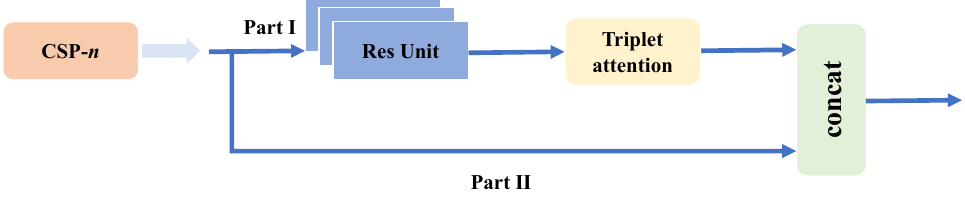
Figure 2. Triplet attention